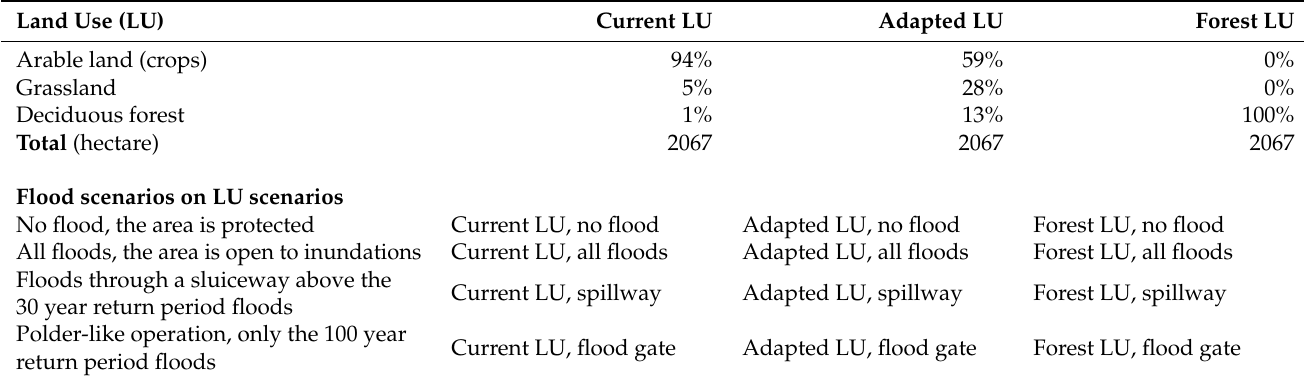
Table 4. Land use ratios, combined scenario definitions and